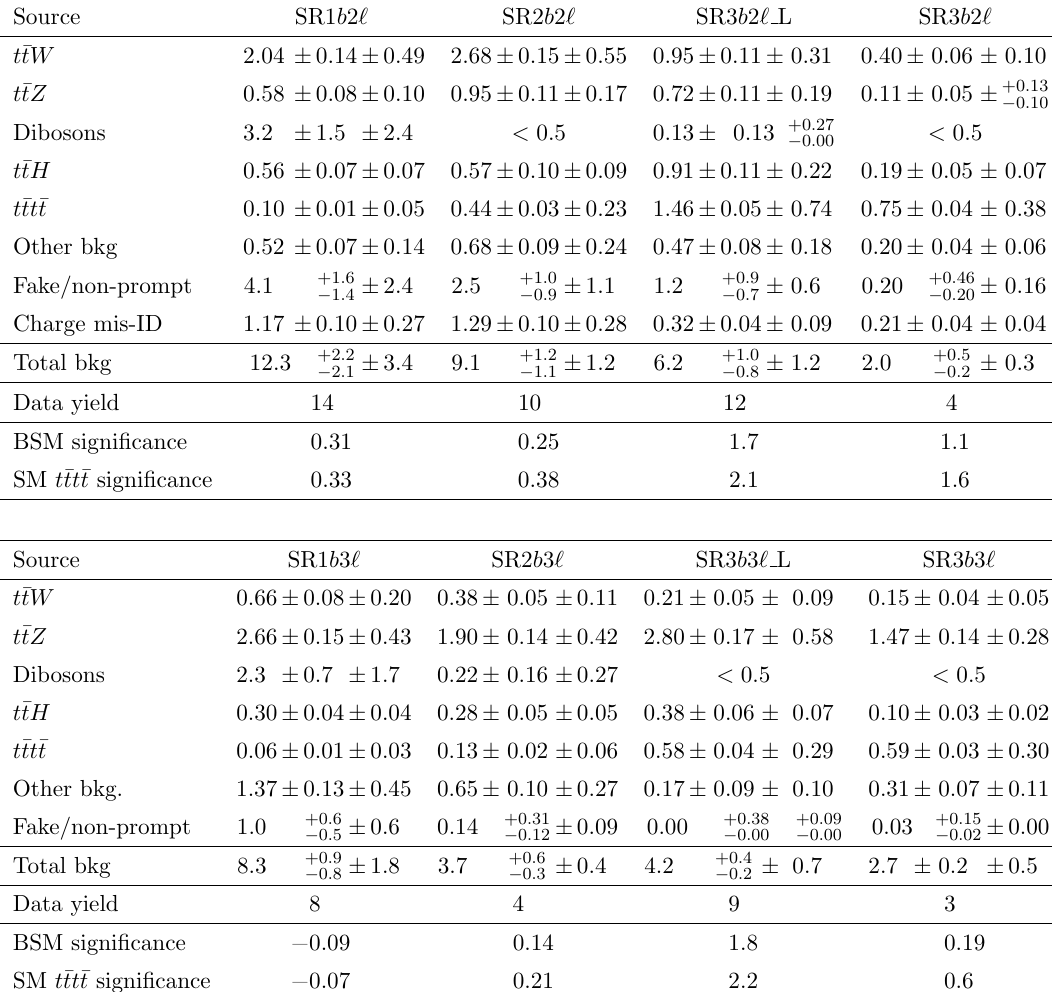
Table 12 . Expected background and observed event yields in the signal regions for the vector-like quark and four-top-quark searches. The ‘Other bkg’ category contains contributions from all rare SM processes listed in section 6. The (cid:12)rst uncertainty is statistical and the second is systematic. The BSM signi(cid:12)cance is the number of standard deviations by which a BSM signal plus background hypothesis is preferred to the background-only hypothesis. Since this signi(cid:12)cance depends only on the event yield and expected background in the given signal region, it is independent of the BSM model. When computing the SM t (cid:22) tt (cid:22) t signi(cid:12)cance, the expected SM t (cid:22) tt (cid:22) t yield is not included in the expected background. Both signi(cid:12)cances are calculated using the same procedure used to calculate the reported